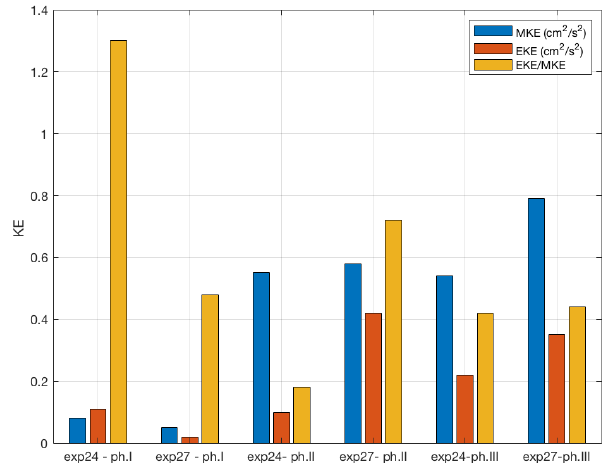
Figure 9. Eddy kinetic energy (EKE) and kinetic energy of the mean motion (MKE) in the surface layer (levels 1–4), spatially av- eraged over the slope area during phases I, II, and III (i.e., before, during, and after the high-density water injection, respectively) for EXP 24 and EXP